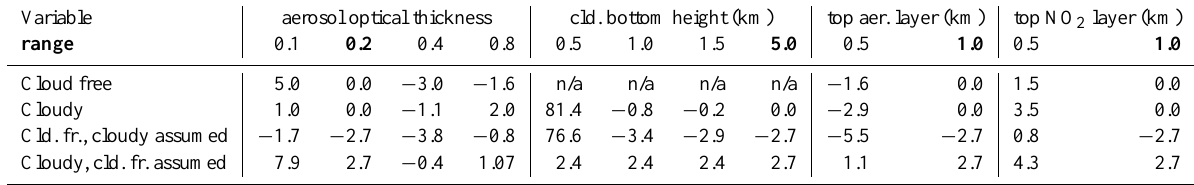
Table 2. Percentage of errors in the retrieved tropospheric vertical NO 2 column, when variables indicated in the upper row are different from the reference value (indicated in boldface). Also shown are the errors made when wrongly assuming a cloud in case of cloud free conditions and vice versa (two bottom rows). Simulations are performed for a solar zenith angle of 60 ◦ and a relative azimuth angle of 180 ◦ . Variable aerosol optical thickness cld. bottom height (km) top aer. layer (km) top NO 2 layer (km) range 0.1